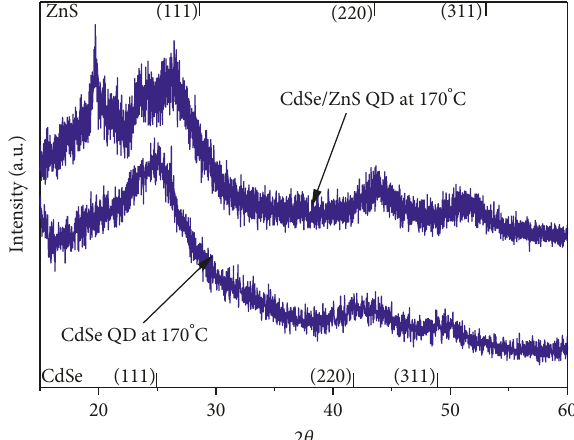
Figure 3: The XRD patterns of (a) bare CdSe core QD prepared at 170 ° C for 2min and at 190 ° C for 15 min, respectively, and (b) core/ shell CdSe/ZnS QDs and corresponding bare CdSe core QDs prepared at 170 ° C for 2min reaction